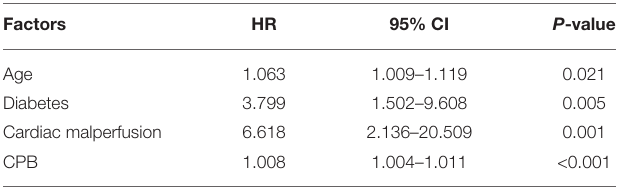
TABLE 5 | Multivariable Cox-hazard regression analysis results for short and mid-term overall